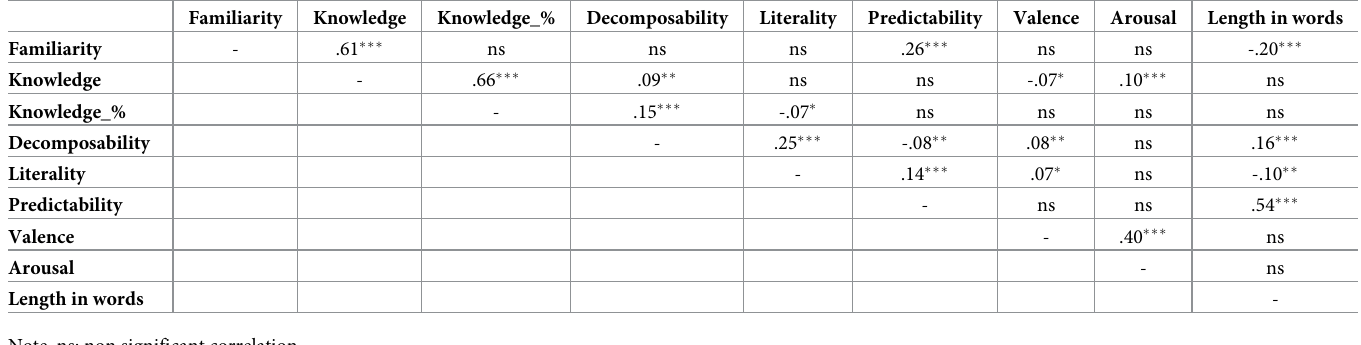
Table 2. Partial correlations between the variables in the